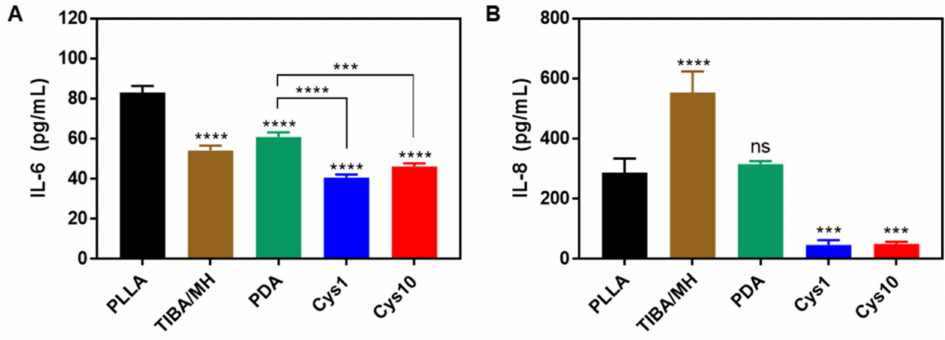
Figure 5. The expression levels of cytokine factor ( A ) IL-6 and ( B ) IL-8 in the proliferation of HCAECs on the coated films for 24 h (*** p < 0.001, **** p < 0.0001 vs. PLLA).